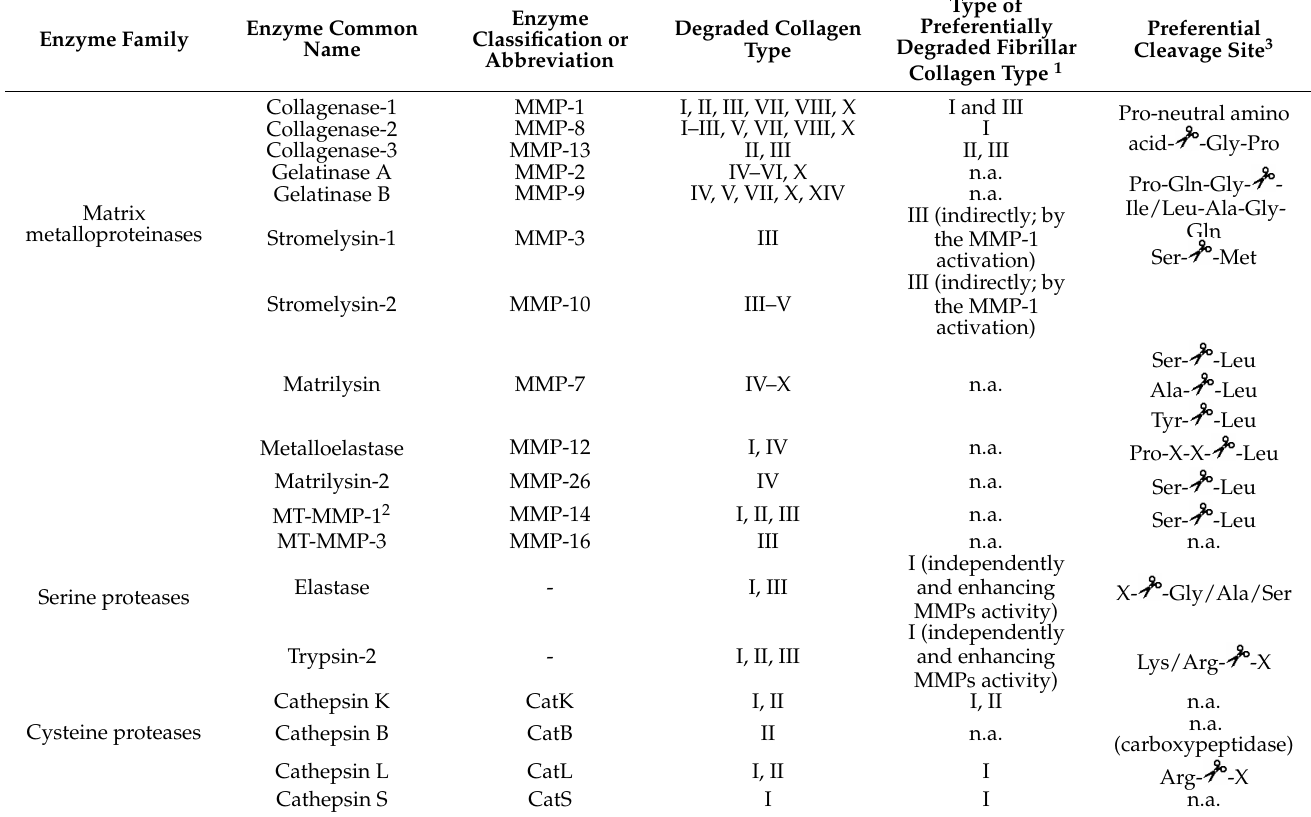
Table 1. Major enzymes involved in the extracellular degradation pathway of collagen